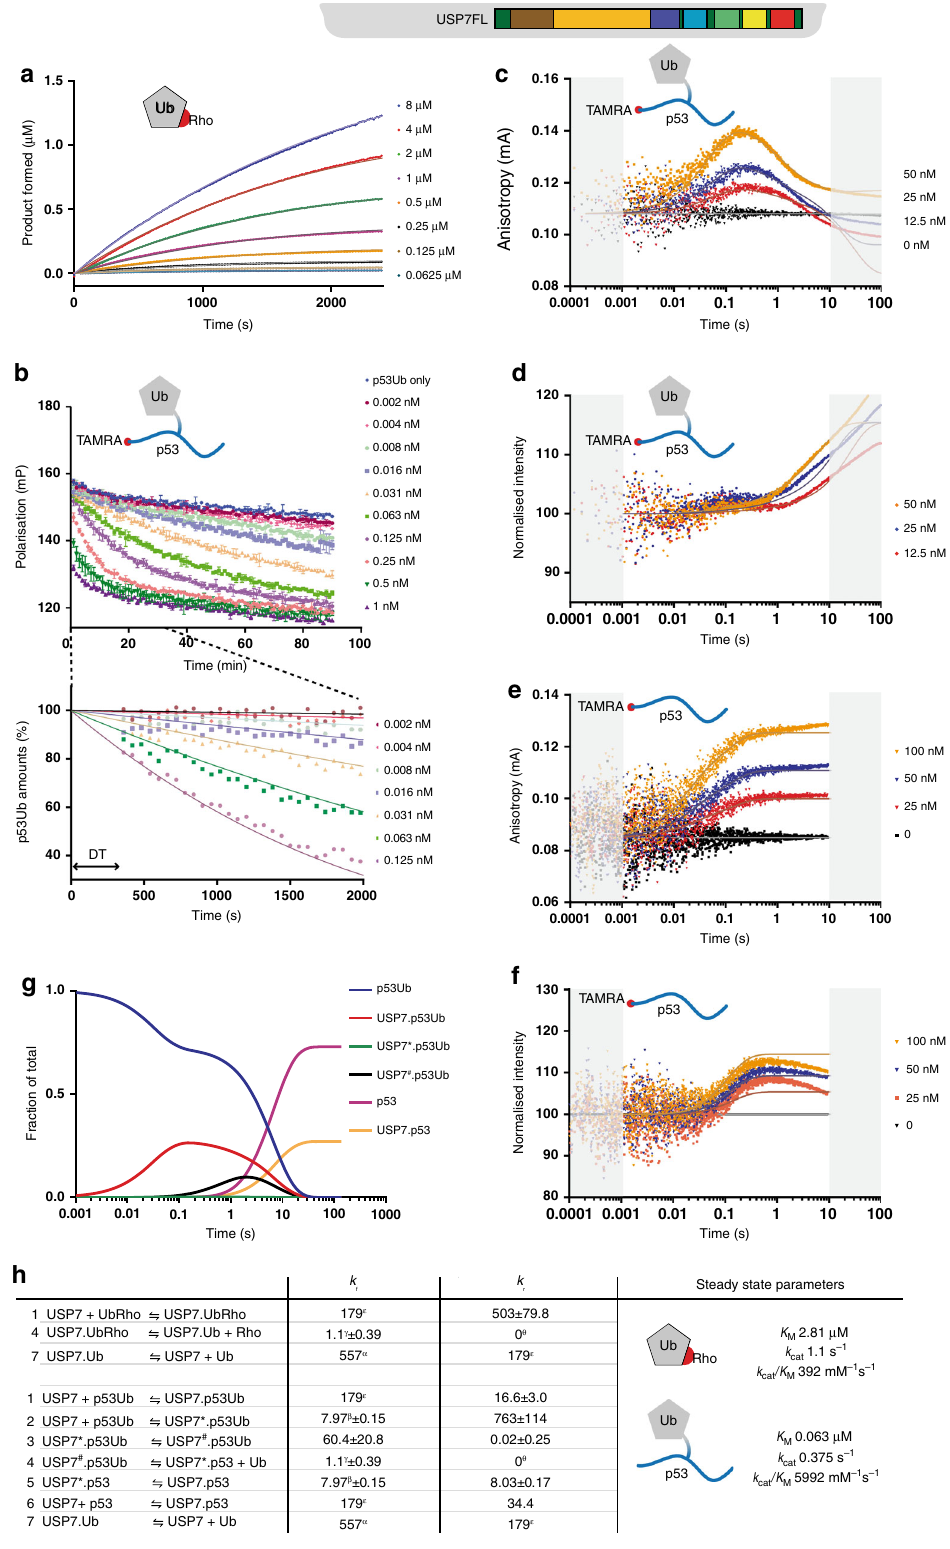
Kinetic analysis of USP7 activity on p53 model substrate . To model these multiple steps we describe every phase, with as few reaction steps as possible. We imported the raw stopped- fl ow, FP and activity data into KinTek 51 and scaled the data based on